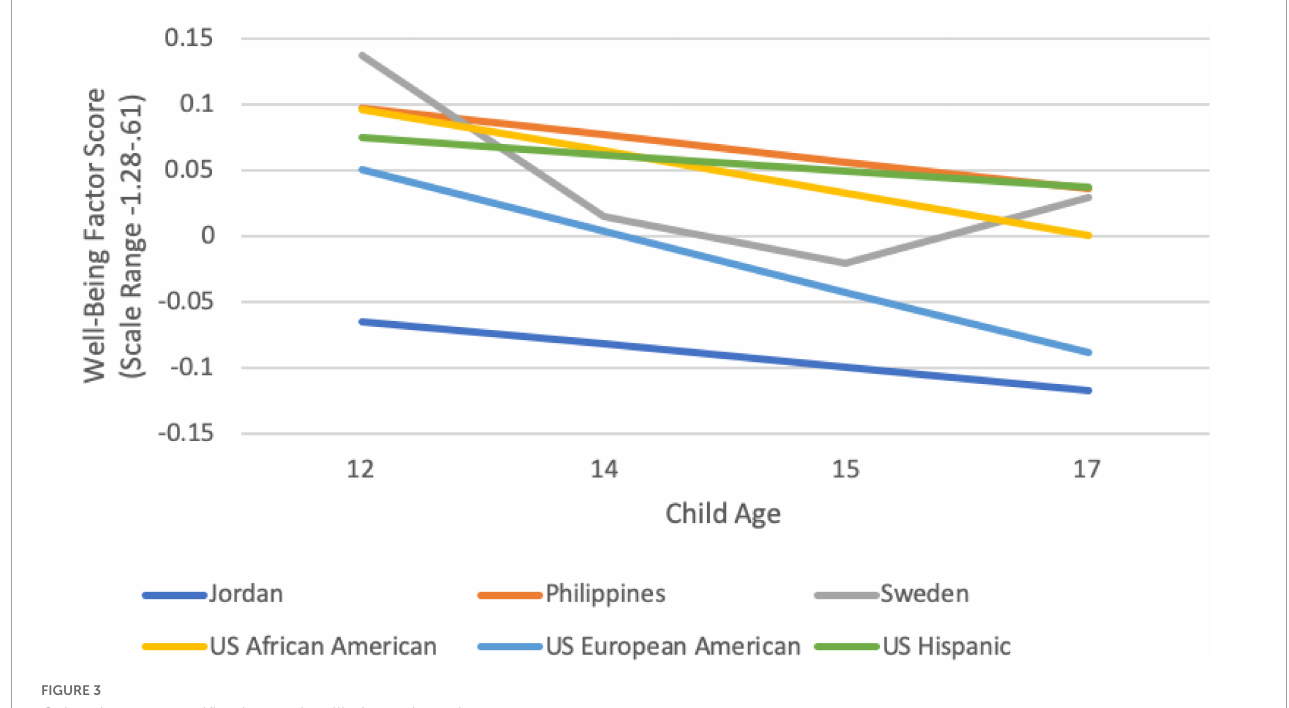
FIGURE3 Cultural group-specific observed wellbeing